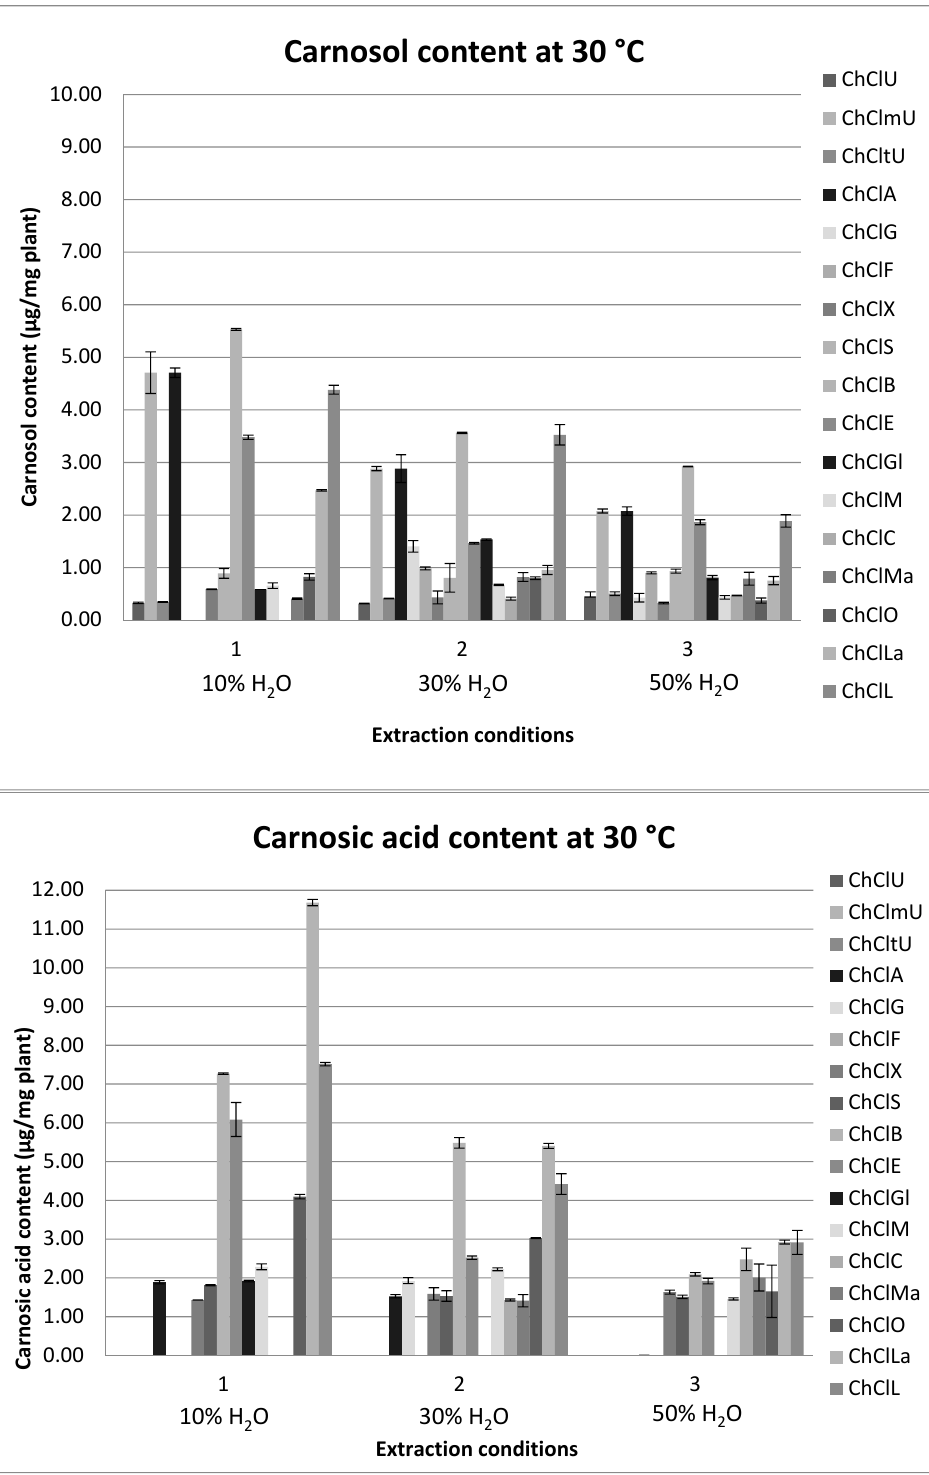
Figure A1. Carnosol and carnosic acid content obtained by stirring and heating with DESs depending on the temperature and H 2 O content ( n = 3). The columns represent determined amount of carnosol and carnosic acid in the samples, and the color of the column indicates DES used according to the abbreviations recorded in the legend to the right and Table 4.